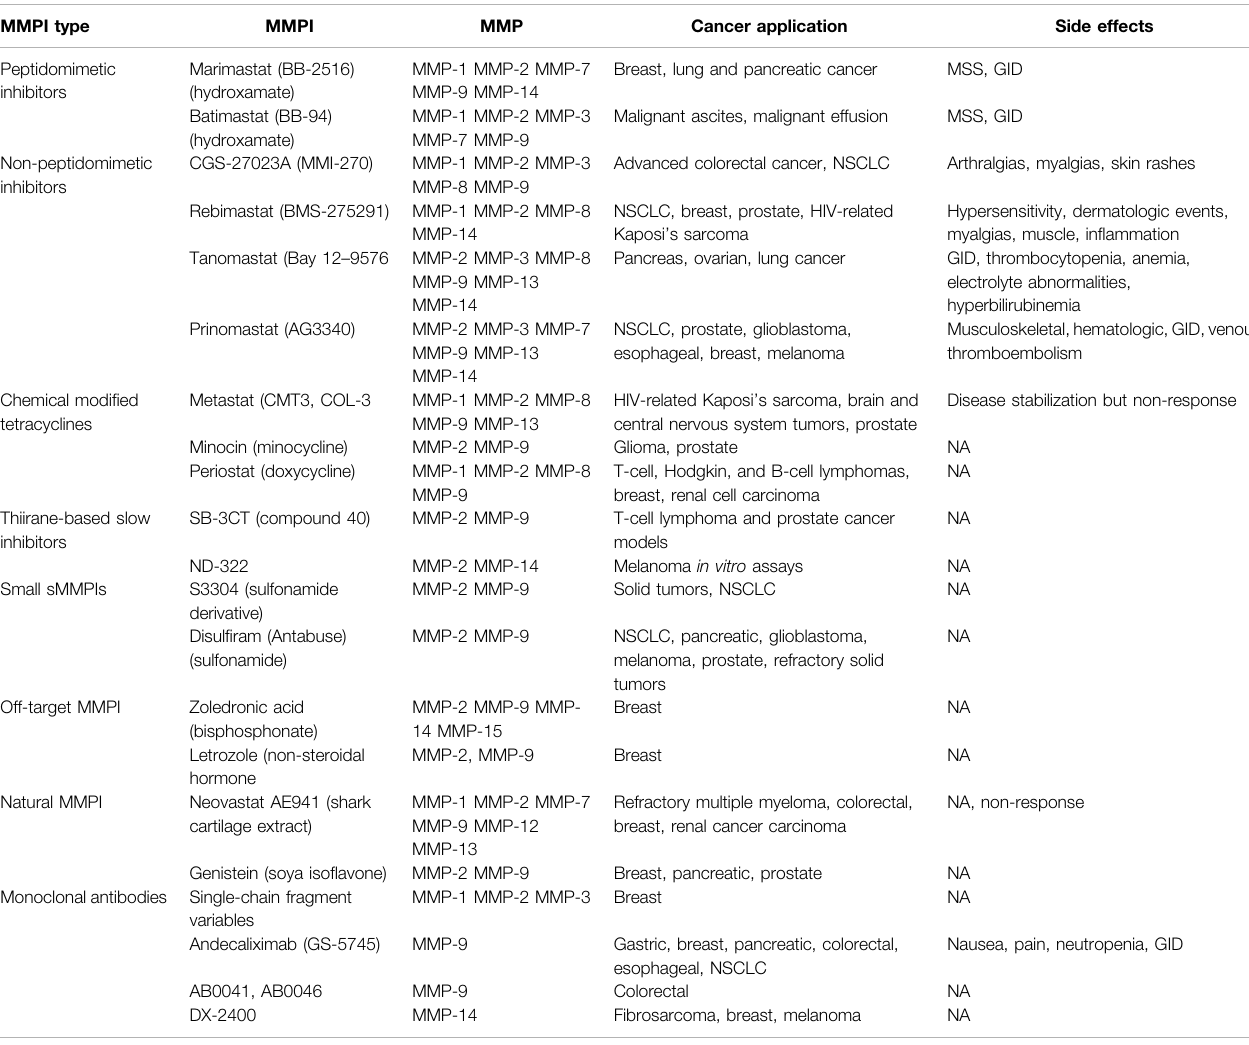
TABLE 4 | Table MMPs ’ inhibitors used in cancer